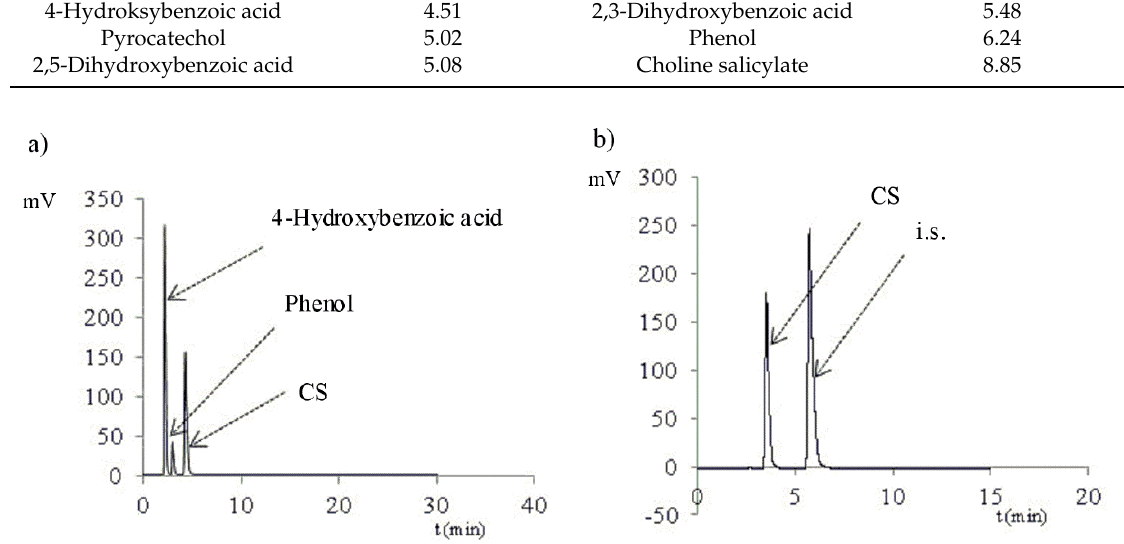
Figure 2. Exemplary HPLC chromatograms: ( a ) Mixtures of 4-hydroxybenzoic acid (50 µ g / mL), phenol (50 µ g / mL), and CS, (200 µ g / mL)) and of ( b ) CS (80 µ g / mL) and propyl 4-hydroxybenzoate (i.s., 100 µ g / mL) are plotted against a mobile phase flow of 1.0 mL and detection at 270 nm ( a ) or 230 nm ( b ).